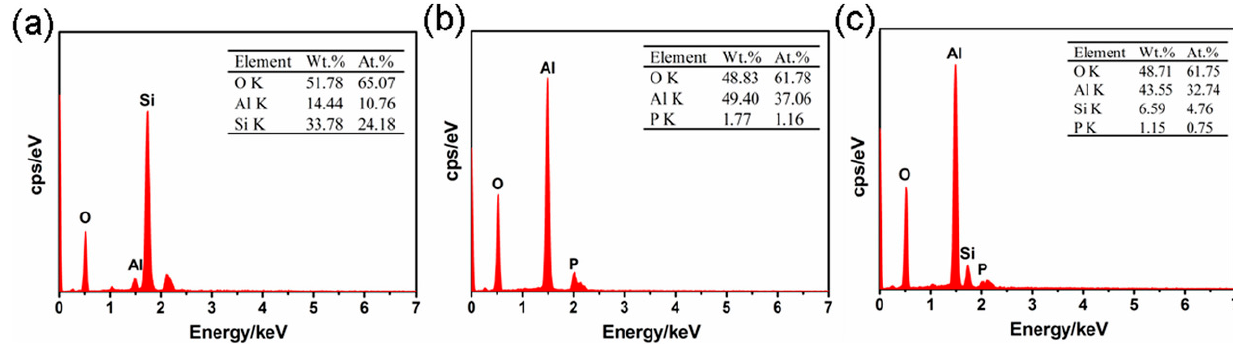
Figure 10. EDS spectra for ( a ) Si-coating, ( b ) P-coating, and ( c ) mixed Si-P coating. Reproduced with permission from [40]. Copyright Elsevier, 2020.